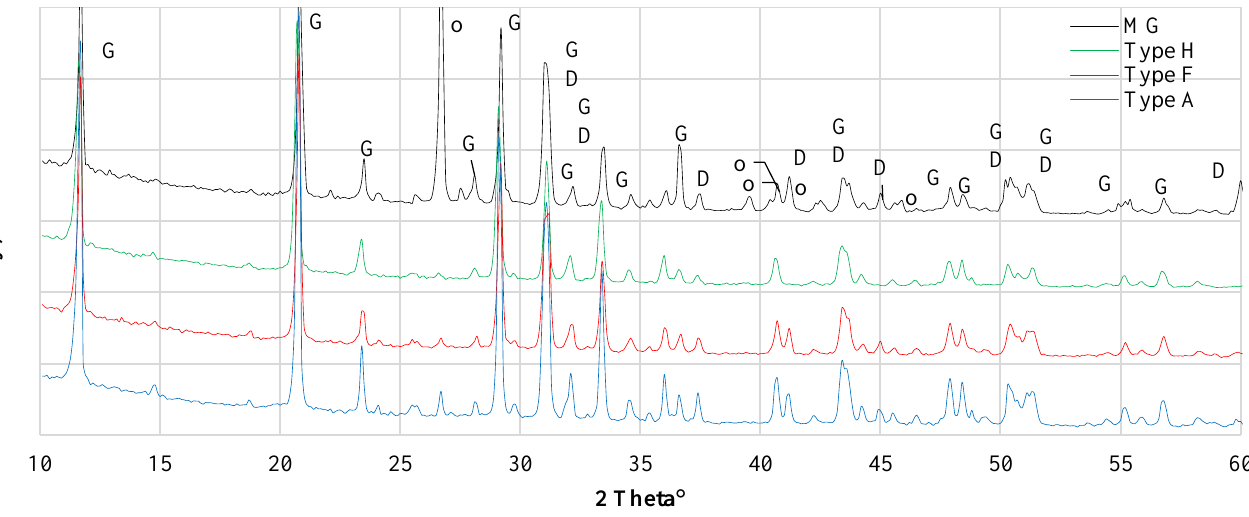
Figure 2. XRD results of different types of gypsum CDW. MG—gypsum monolithic wall CDW; Type H—gypsum drywall, impregnated; Type F—gypsum drywall, fire-resistant; Type A—gypsum drywall, standard. G—gypsum CaSO 4 · 2H 2 O, ref# 021-0816, D—Dolomite, CaMg(CO 3 ) 2 , ref#